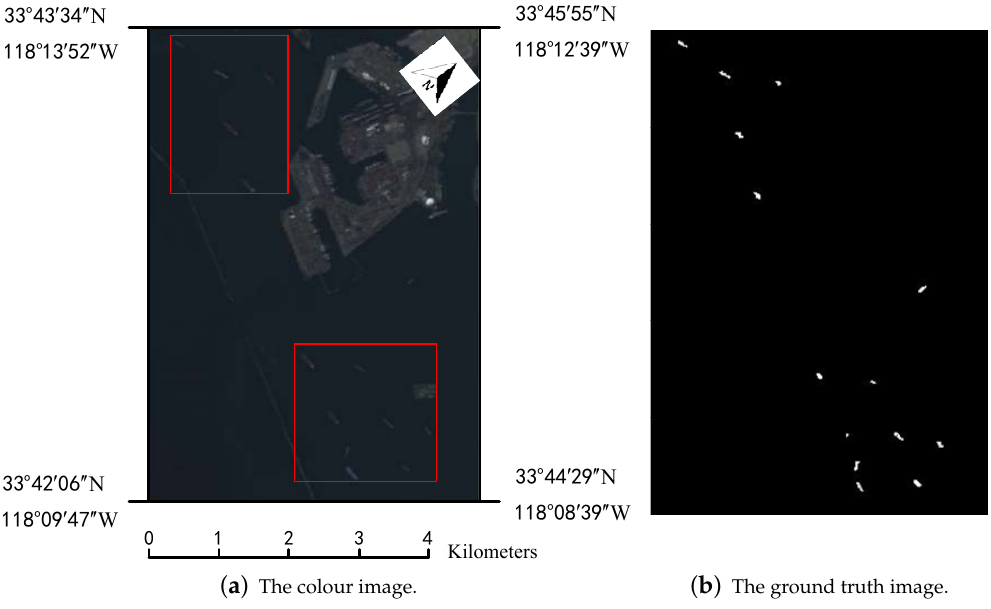
Figure 7. The colour image and the ground truth image of Los Angeles data set.